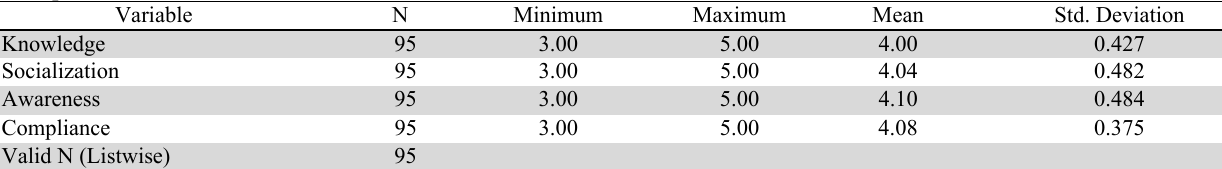
Descriptive Statistics